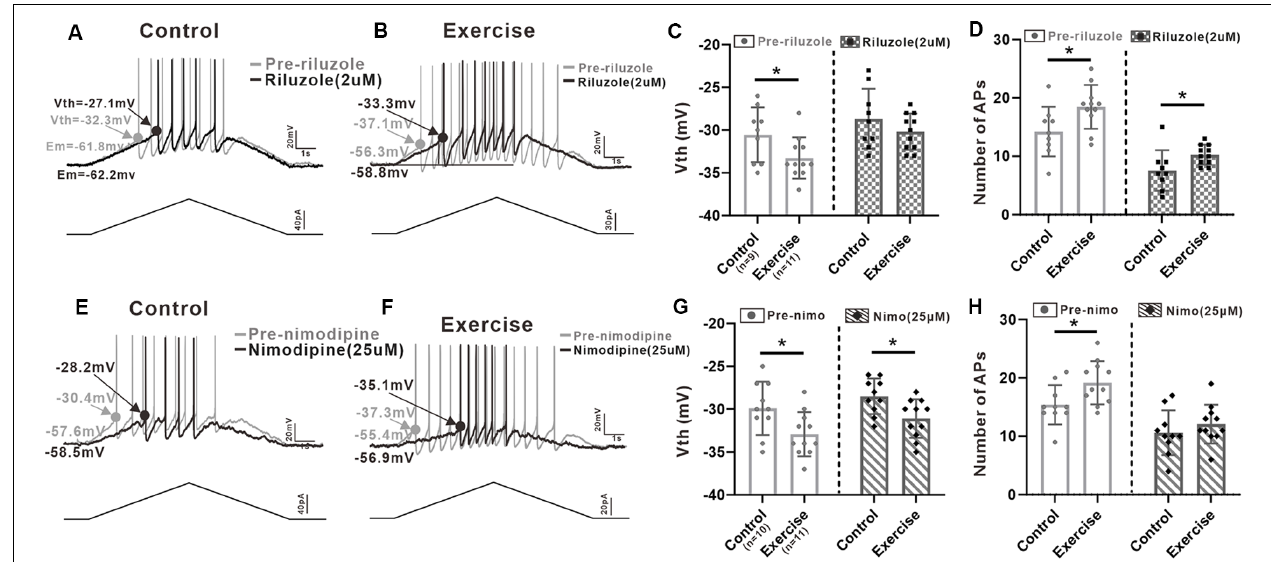
FIGURE 6 | Effects of PICs on neuronal excitability. (A) Example of riluzole (2 µ M, black trace) reduced the firing frequency of 5-HT neuron compared to that of pre-riluzole (gray trace) and depolarized the Vth in control group. (B) Example of riluzole (2 µ M, black trace) reduced the firing frequency of 5-HT neuron compared to that of pre-riluzole (gray trace) and depolarized the Vth in the exercise group. (C) Exercise training significantly depolarized the Vth (left panel, unpaired Student’s t -test, p = 0.044). After administration of riluzole, there was no significant difference in Vth between the control and exercise groups (right panel, unpaired Student’s t -test, p = 0.248). (D) Compared with the control group, exercise training increased the number of APs (left panel, unpaired Student’s t -test, p = 0.029). Even reduced by riluzole, the number of AP measured from the exercise group were still bigger than those from the control group (right panel, unpaired Student’s t -test, p = 0.034). (E) Example of nimodipine (25 µ M) reduced the firing frequency of 5-HT neuron compared to that of pre-nimodipine (gray trace). (F) Example of nimodipine (25 µ M) reduced the firing frequency of 5-HT neuron compared to that of pre-nimodipine (gray trace) in the exercise group. (G) Exercise training significantly hyperpolarized the Vth (left panel, unpaired Student’s t -test, p = 0.026). Significant difference was also observed in Vth between control and exercise groups with nimodipine (right panel, unpaired Student’s t -test, p = 0.013). (H) Compared with the control group, exercise training increased the number of APs (left panel, unpaired Student’s t -test, p = 0.025). After administration of nimodipine, there was no significant difference in the number of APs between control and exercise groups (right panel, unpaired Student’s t -test, p = 0.352). * p <